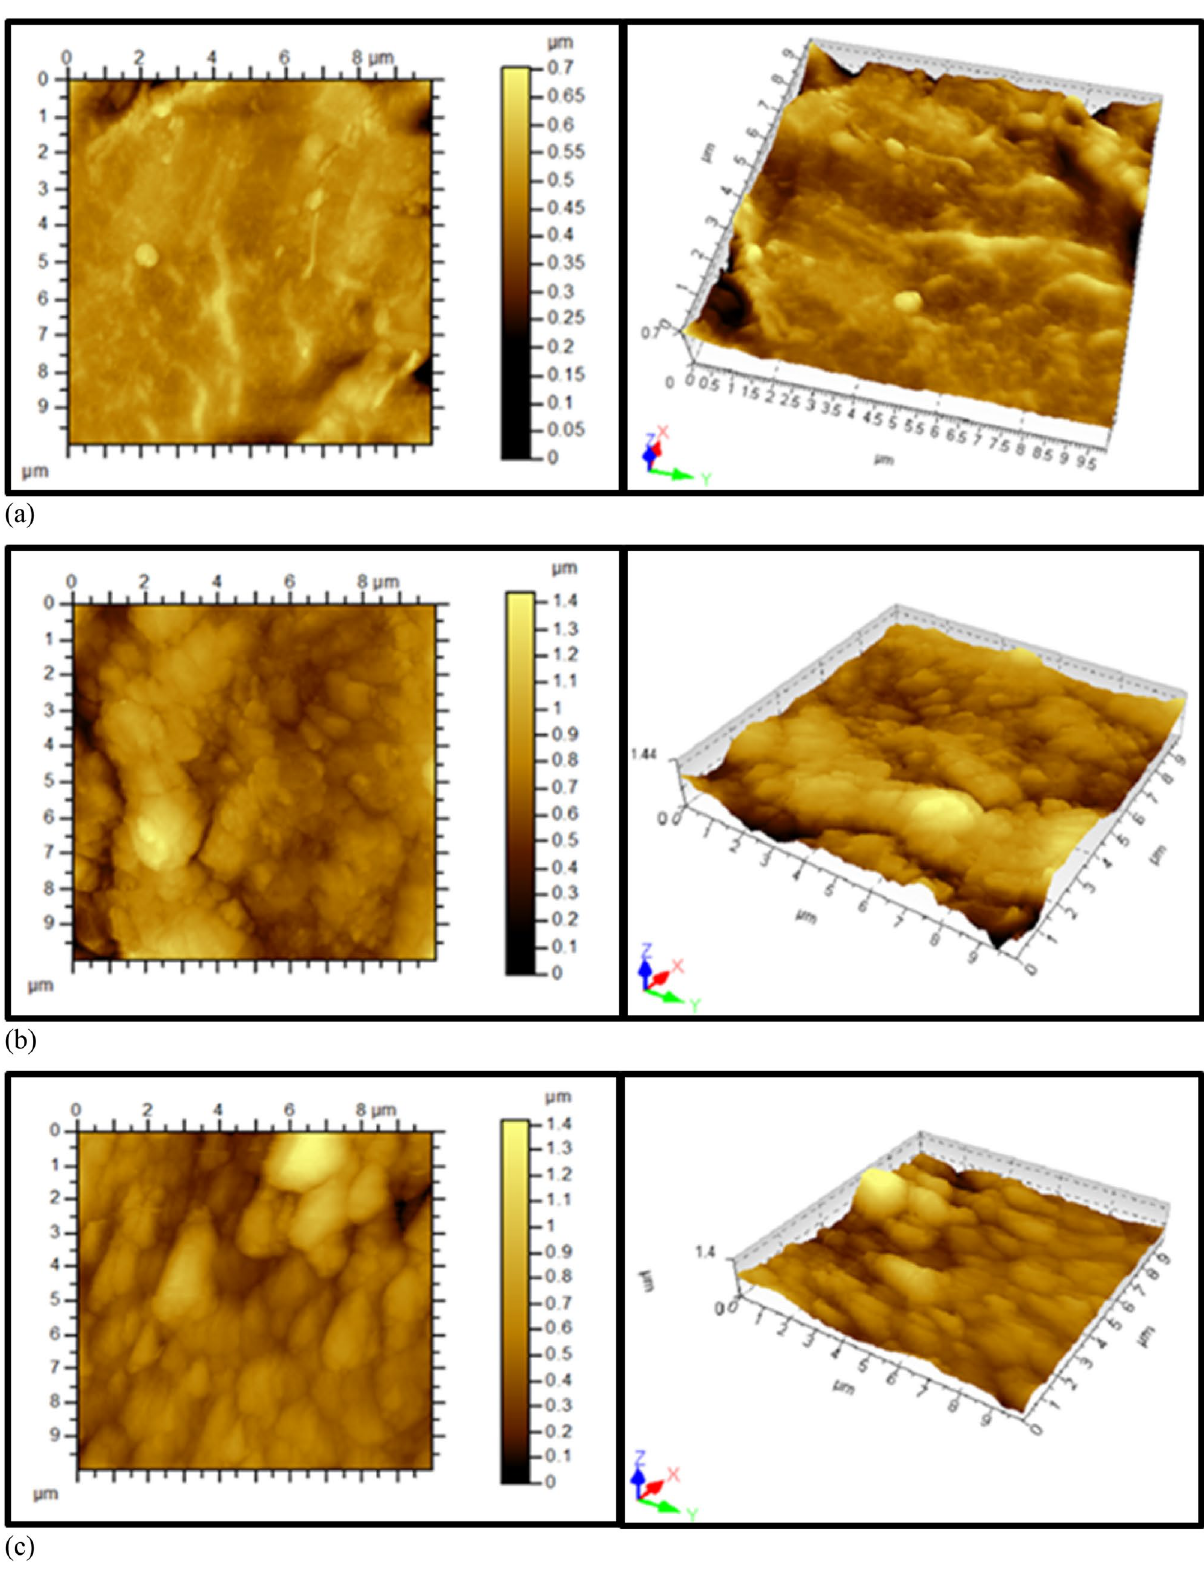
Figure 13. Two-dimensional (left) and three-dimensional (right) AFM images of FeCrAl fibers samples; ( a ) Sample 1 with no heat treatment; ( b ) Sample 2 after one MSHT cycle; ( c ) Sample 3 after eighteen MSHT